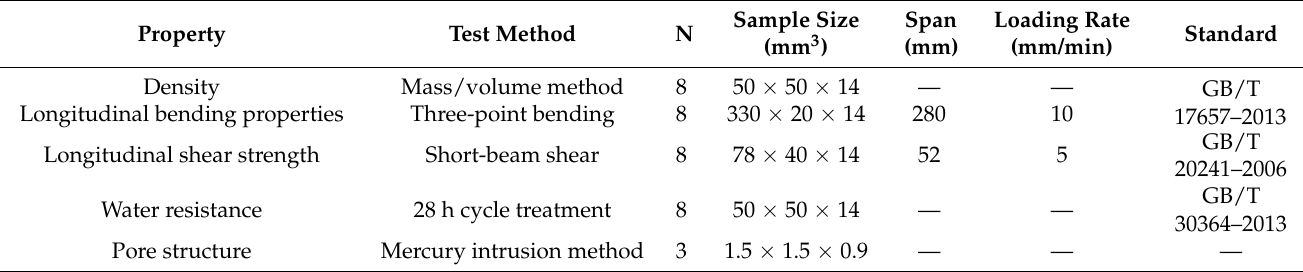
Table 1. Experimental test details for LC